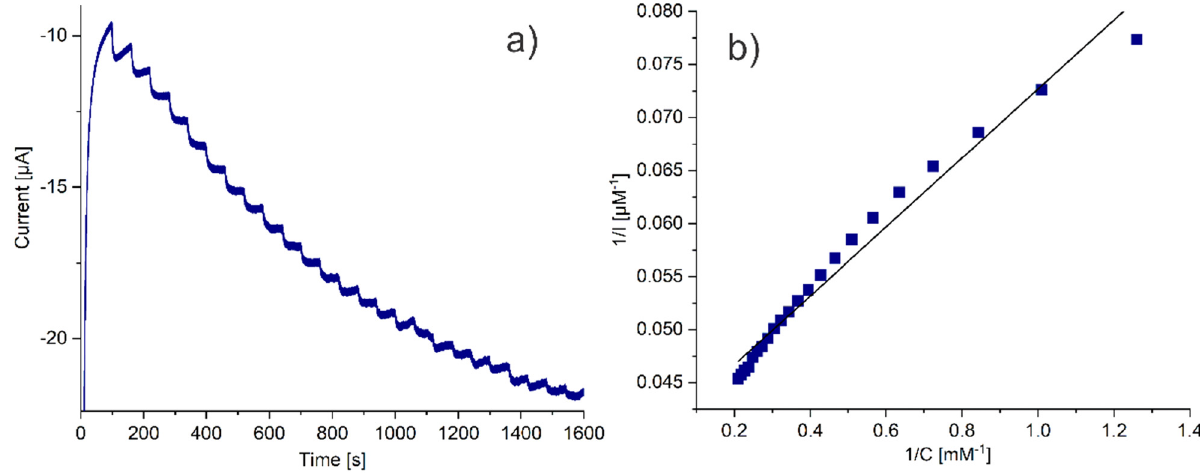
Figure A6: ( a ) Amperometric response of the SPCE/PAni/AuNP/cMWCNT/CAT biosensor towards successive addition of H 2 O 2 and ( b ) Lineweaver – Burk plot of 1/ I k ss versus 1/C H 2 O 2 for the determination of m for the SPCE/PAni/AuNP/cMWCNT/CAT